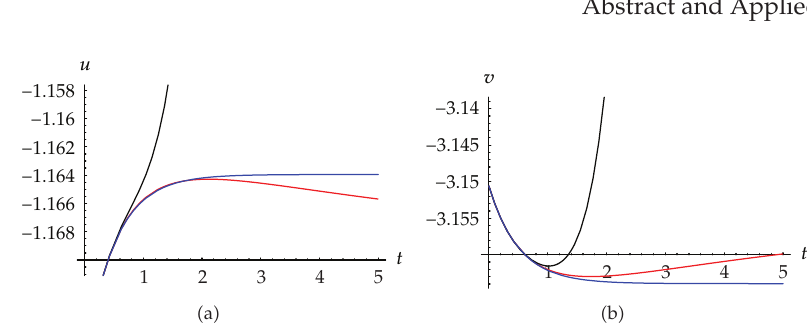
Figure 5: The compared results for the GDTM solutions (cid:4) black (cid:5) , the GDTM-Pad´e solutions (cid:4) red (cid:5) , and the exact solutions (cid:4) blue (cid:5) of (cid:4) 1.2 (cid:5) when c (cid:8) 1, d (cid:8) 0 . 5 and n (cid:8) 5.